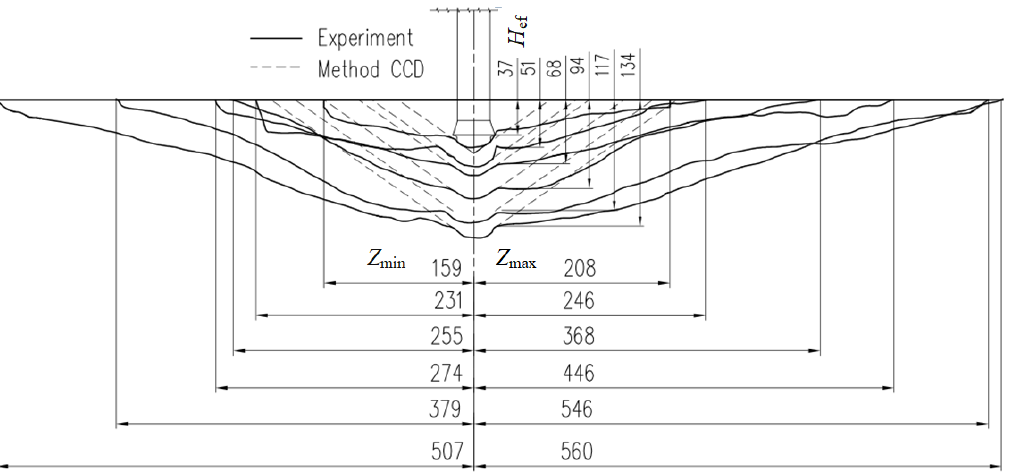
, maximum Z , and minimum ef max